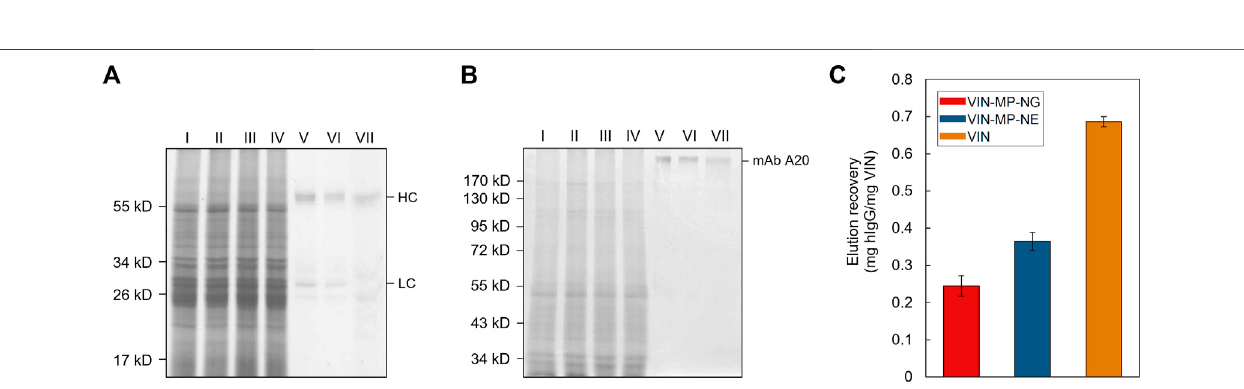
FIGURE 6 | Screening and evaluation of plant virus-based immunosorbent nanoparticle-coupled magnetic particle (VIN-MP) coupling density and human immunoglobulin G (hIgG) elution. (A) 1-Ethyl-3-(3-dimethylaminopropyl) carbodiimide (EDC) concentration used during coupling and resultant coupling density for amine-terminated magnetic particles. VIN-MP coupling density and hIgG elution recovery for both amine- and carboxyl-terminated magnetic particles (B) per MP mass basis, and (C) per VIN mass basis. Fits are generated as 3rd order polynomials. Elution recoveries of hIgG from PBS are shown over a range of hIgG loading densities for amine-terminated MP (VIN-MP-N) with 5% glutaraldehyde coupling (VIN-MP-NG), 0.5 mg/ml EDC coupling (VIN-MP-NE), and uncoupled VIN in free suspension (D) per VIN mass basis, and (E) as an extent of the loading density and of hIgG from PBS.